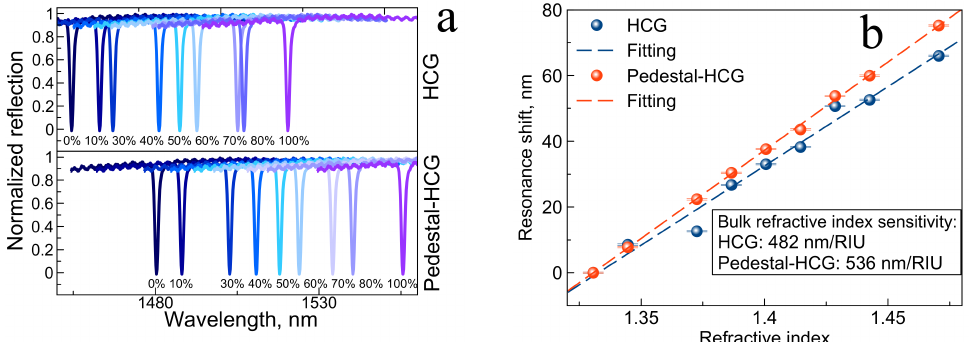
Figure 4. ( a ) Reflectance spectra of the HCG (top part) and the pedestal HCG (bottom part) in glycerol-aqueous solutions, ( b ) resonance wavelength of the HCG (blue) and PHCG (red) versus the change in RI associated with different glycerol concentration in the solution.